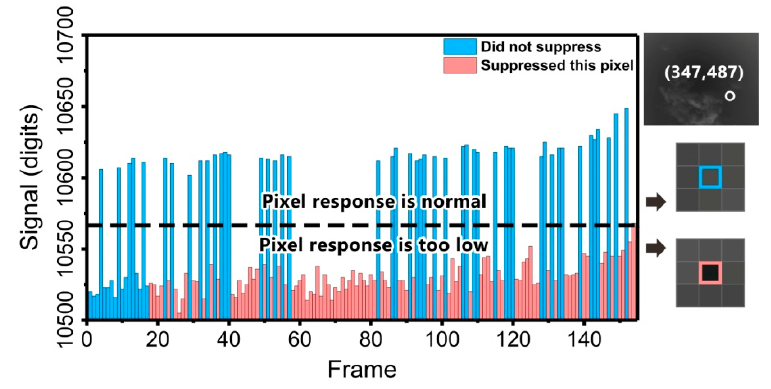
Figure 9. The suppression situation of pixel (347,487) in the second sequence of cloud scenario. Meanwhile, we use the simulated data to make a quantitative analysis on the flickering pixel suppression. Figure 10 shows the randomly added flickering pixels and miss-suppressed flickering pixels of our method. Additionally, Figure 10a–d is sky background, sky background with IRPT, deep space background, and deep space background with IRPT, respectively. Blue points show the flickering pixels added randomly, red circles indicate the flickering pixels which miss-suppressed by our proposed method. We calculate the N sf , R fbp , and R fsf mentioned in Section 3.2 of different simulated scenarios in Table 5. The results showed that there is no false suppression of flickering pixels in all scenarios. In addition, the miss suppression rate of flickering pixels is less than or equal to 2.38% in all scenarios.